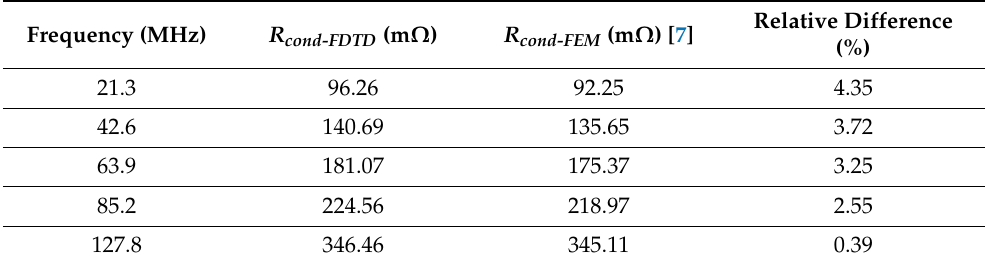
Table 1. Coil conductor resistance estimation for different frequencies (non-segmented loop). FDTD and FEM calculation results.